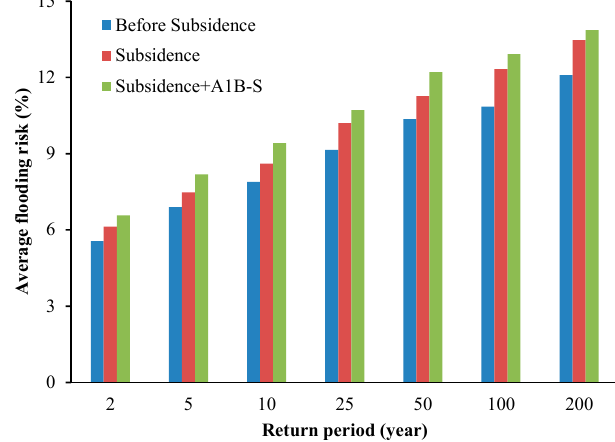
Figure 17. Average inundation risk for a one-day storm under different return periods and scenarios.